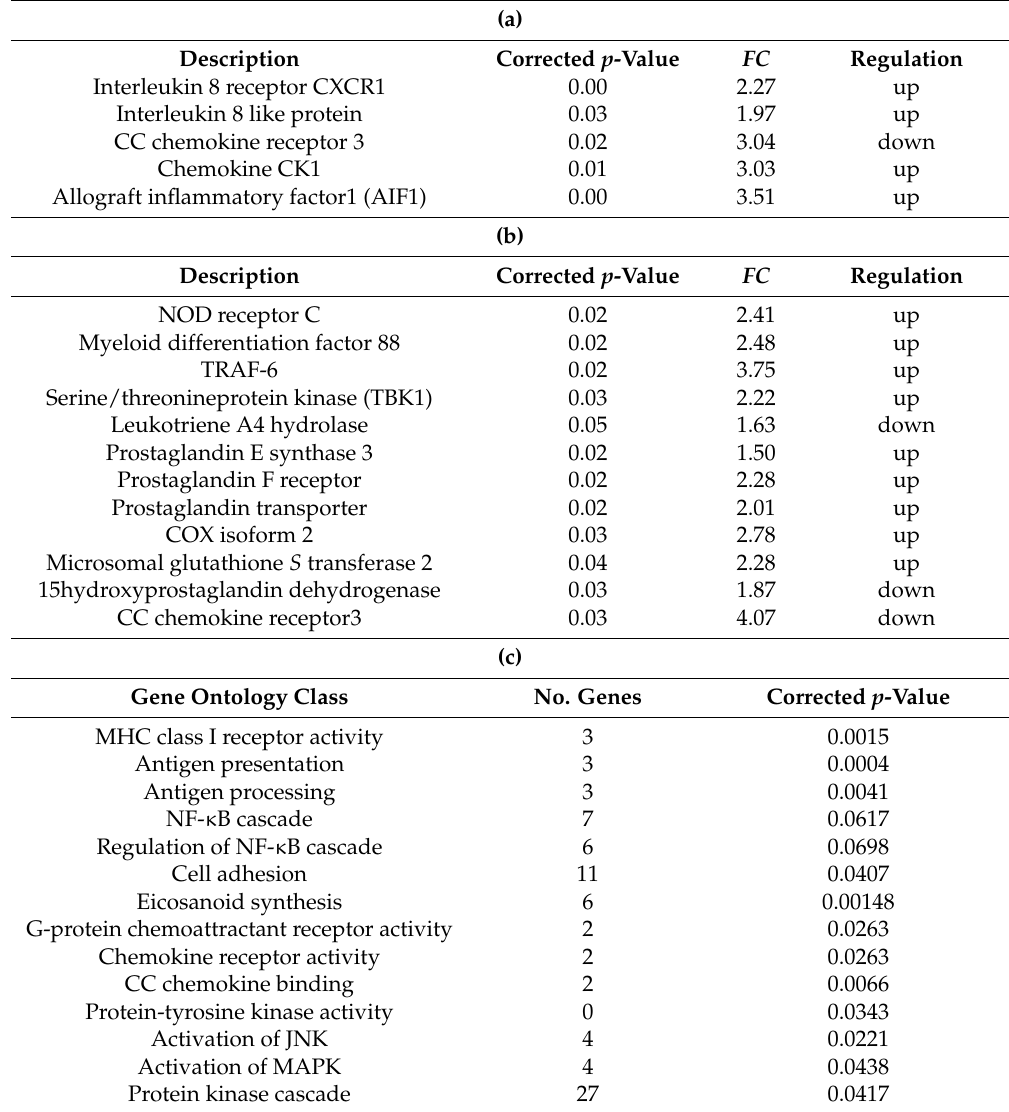
Table 3. ( a ) Selected transcripts expressed in macrophages under LPS (6 h) treatment; ( b ) selected transcripts expressed in macrophages under PGN (6 h) treatment; and ( c ) overexpressed GO categories ( p < 0.01) of the macrophage transcripts expressed after treatment with PGN (6 h) (No. Gene column shows the number of transcripts overexpressed in each GO